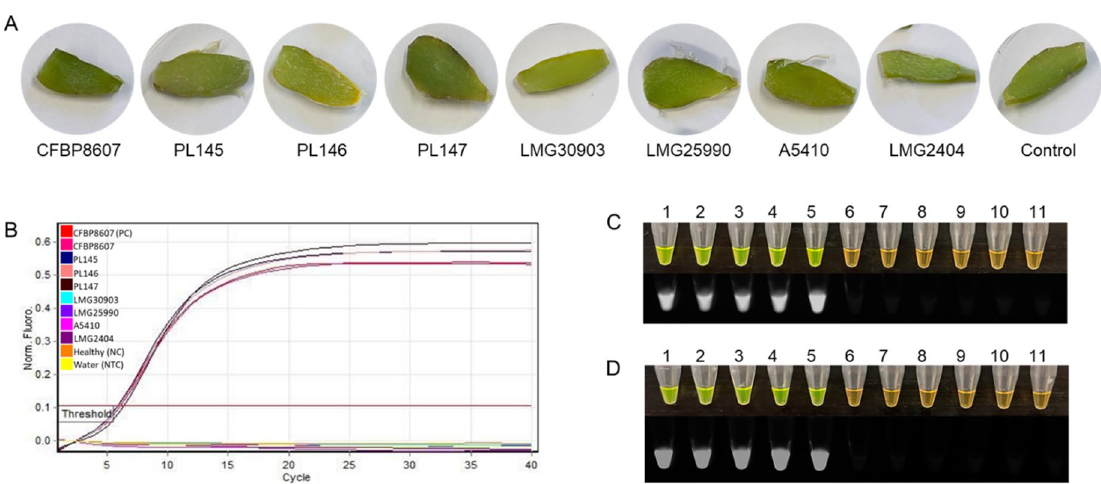
Figure 9. Detection of Dickeya fangzhongdai in artificially infected orchid samples. ( A ) Orchid stems infected with different Dickeya spp. and a Pectobacterium species; D. fangzhongdai CFBP8607 T and PL145-PL147, D. undicola LMG30903, D. solani LMG25990, D. oryzae A5410, P. carotovorum LMG2404, and Control (healthy orchid). ( B ) Sigmoid curve diagram—only D. fangzhongdai infected orchid stems were positive, no curve was observed for other Dickeya spp., P. carotovorum LMG2404, NC (negative control; healthy orchid) and NTC (non-template control; water). ( C ) Rotor-Gene amplification reactions were used for visualization of the LAMP product by adding SYBR Green I dye. Green: positive amplification, orange: no amplification. Visualization of SYBR Green I dye results under UV exposure–fluorescence indicates positive amplification. ( D ) Dry bath amplification reaction was used for visualization of the LAMP product by adding SYBR Green I dye. Visualization of SYBR Green I dye results under UV exposure. 1–2, D. fangzhongdai CFBP8607 T (purified gDNA and DNA from infected sample); 3–5, D. fangzhongdai PL145-PL147; 6–9 D. undicola LMG30903, D. solani LMG25990, D. oryzae A5410, P. carotovorum LMG2404; 10–11 healthy orchid (NC) and water